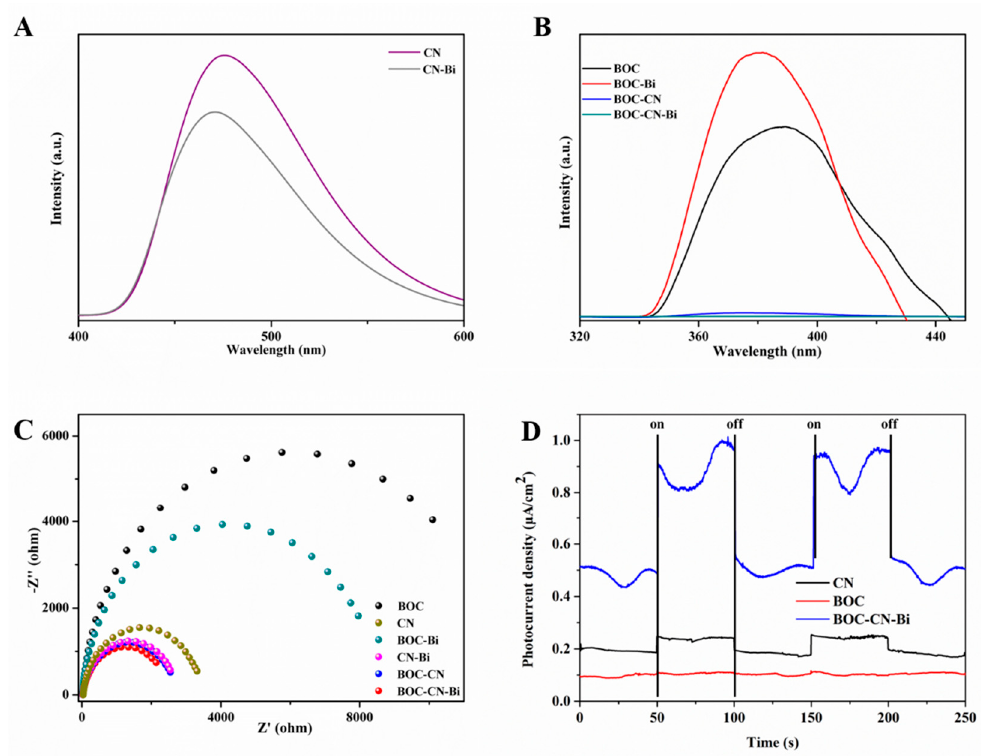
Figure 7. The PL ( A , B ), Nyquist ( C ) and photocurrent spectra ( D ) of over as-prepared samples. Mott-Schottky was used to study the conduction band of CN. The conduction band of CN is − 1.1 V. According to our previous studies, BOC has a conduction band of 0.33 V [43]. The valence band of BOC and CN is severally 3.5 and 1.28 V according to E g = E VB − E CB . In consideration of the dominant active species, the elevated carrier separation efficiency and the relative band positions of BOC and CN, we designed and discussed a novel indirect heterojunction system to expatiate the feasible reaction mechanism of BOC-CN-Bi photocatalysts for degrading pollutants (Figure 8). When illuminated by visible light, both BOC and CN could produce photoinduced electrons in the conduction band. Simultaneously, the valence band of BOC and CN left a lot of holes. Metal Bi with excellent conductivity could readily capture and transmit electrons. Therefore, the electrons of BOC tended to transfer to metal Bi and consumed the holes of CN because of their different band level, greatly improving the separation efficiency of e − –h + pairs. The bi bridge was responsible for the elevated separation efficiency of carriers between BOC and CN, which was proved by the mentioned electrochemical and PL results. As a result, the electrons of BOC combined with the holes of CN resulted in the agglomeration of h + in the VB of BOC (3.5 V) and e − in the CB of CN ( − 1.1 V) for efficient carrier separation. The reductive electrons in the CB of CN could reduce the absorbed O 2 to O 2 − due to E(O 2 /O 2 − ) = − 0.33 V [44,45]. Ultimately, the holes of BOC together with the produced · O 2 − were able to degrade the adsorbed organic pollutants. The remarkably better photocatalytic degradation performance for the ternary BOC-CN-Bi composites was beneficial from the intensive separation of carriers and the extended visible-light absorption range.